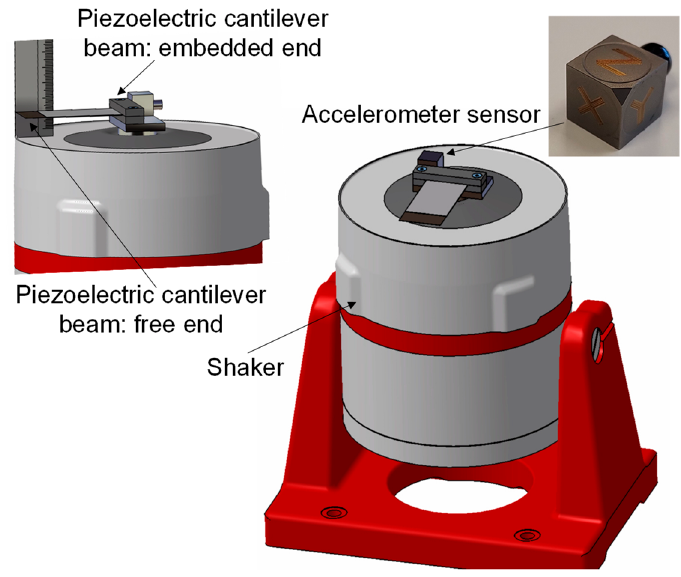
Figure 3. Schematic representation of the experimental setup for the measurement of the characteristic parameters of the piezoelectric bimorph harvester. The vibration system transmits a sinusoidal movement to the embedded end of the harvester at the selected acceleration. The amplitude and the frequency of the excitation signal were measured by an accelerometer sensor placed at the fixed end of the beam.